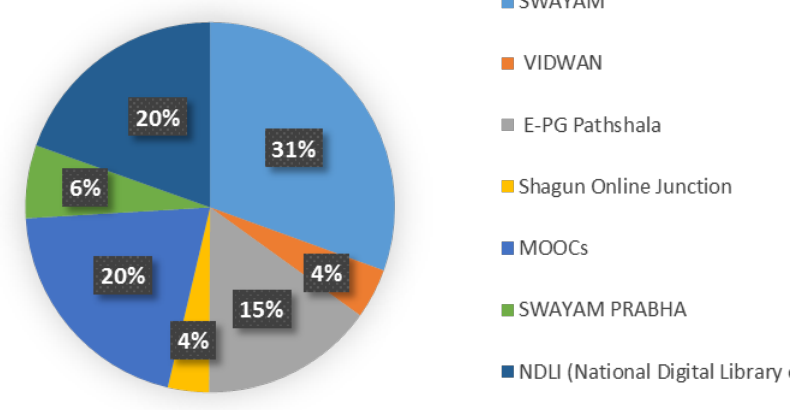
Figure - 2: Showing mostly used online learning